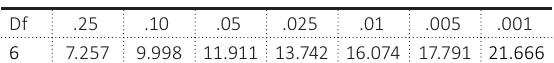
Table 3. Critical values